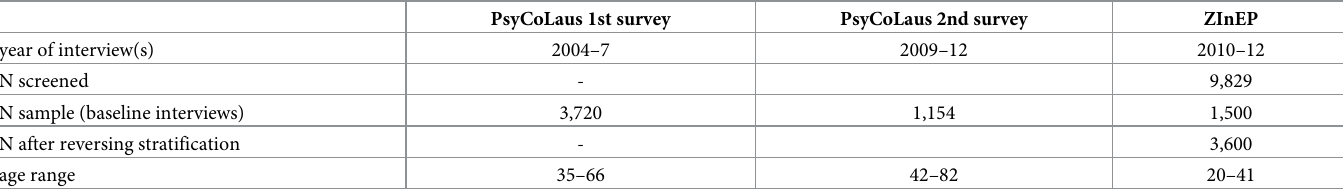
Table 1. Characteristics of PsyCoLaus and the ZInEP epidemiology